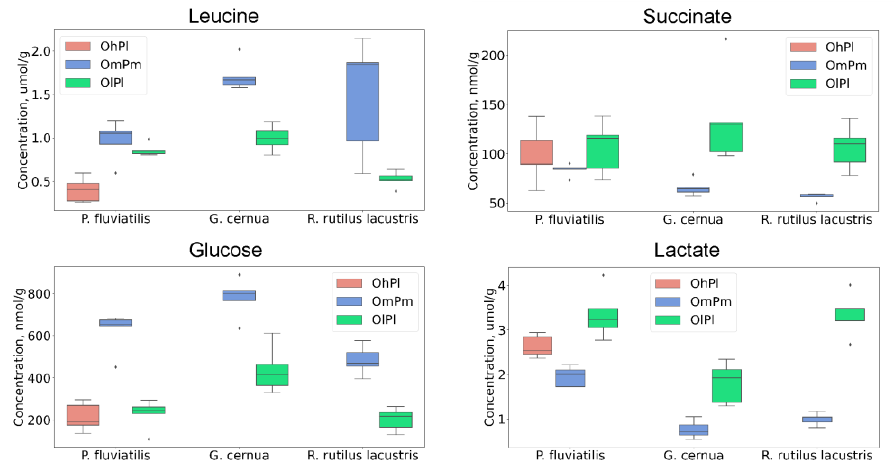
Figure 3. Boxplots for concentrations of leucine, succinate, glucose, and lactate in lenses of P. fluviatilis , R. rutilus lacustris , and G. cernua from the Nigiya River (green, OlPl), Lake Borovoye (red, OhPl), and the Ob Reservoir (blue, OmPm). Rhombs indicate outliers.